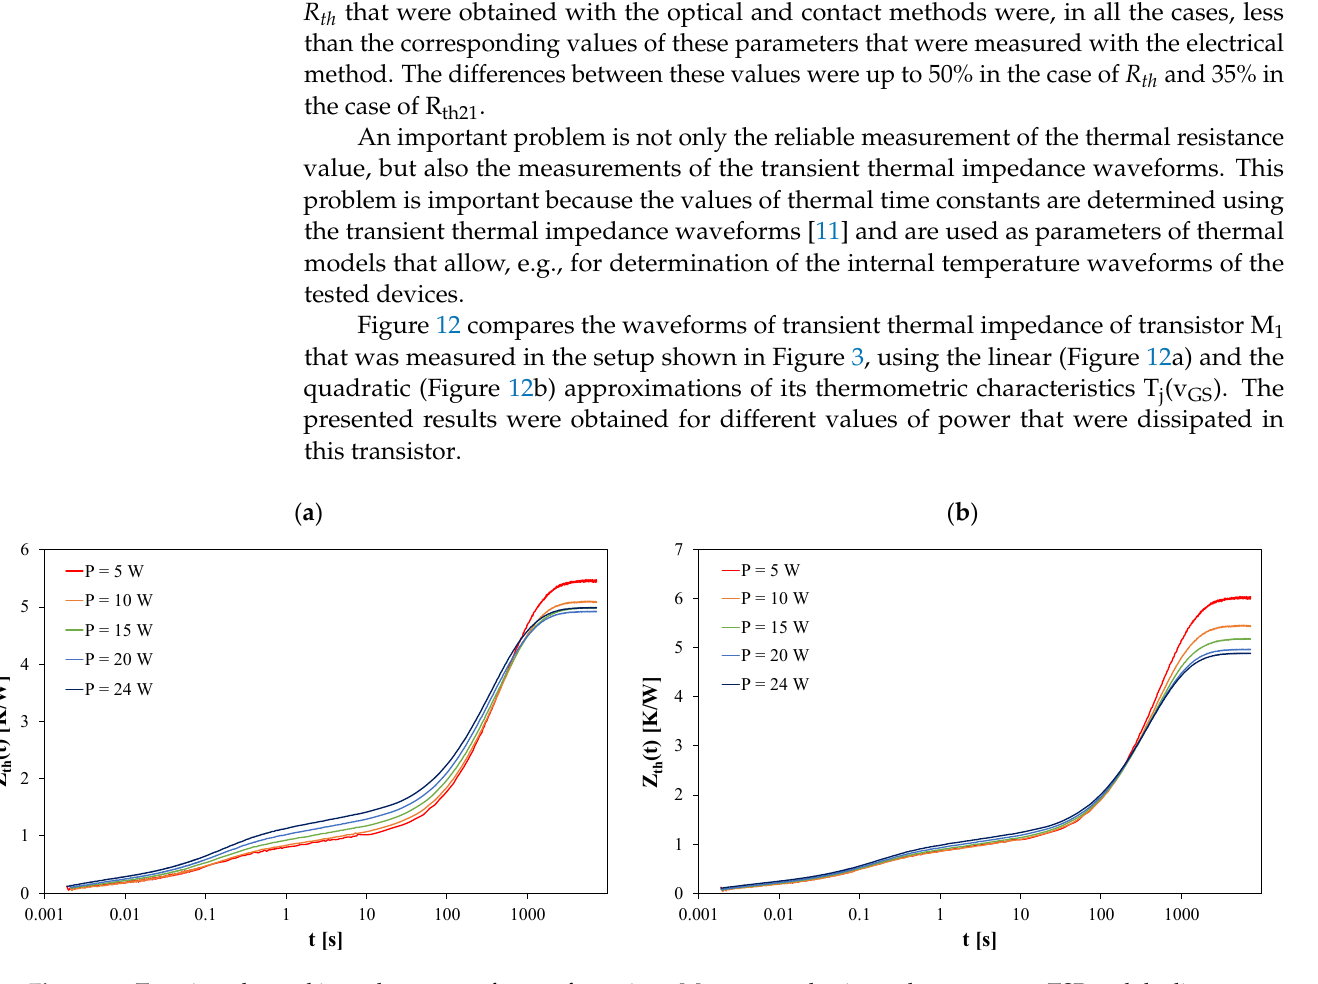
Figure 12. Transient thermal impedance waveforms of transistor M 1 measured using voltage v GS as a TSP and the linear ( a ) and quadratic ( b ) thermometric characteristic